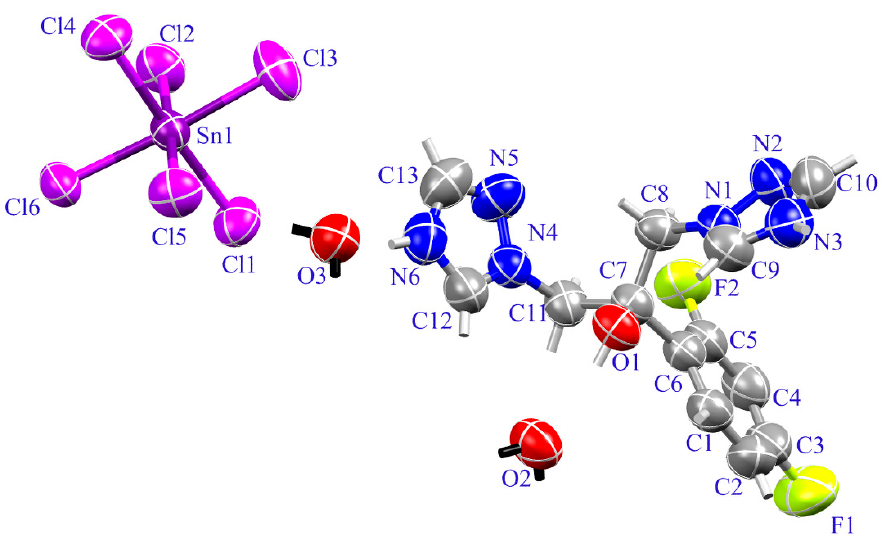
Figure 1. Asymmetric unit of (H2Fluconazole).SnCl6.2H 2 O with 50% probability ellipsoids.